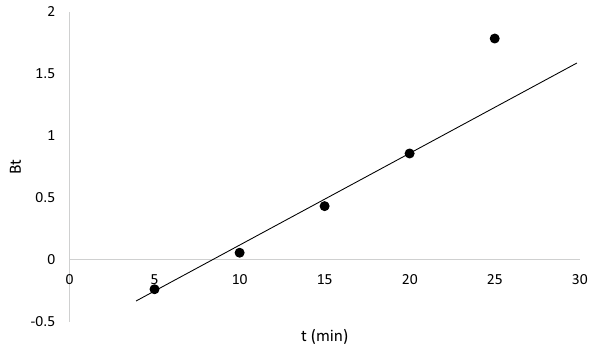
-0.500.511.522.53 Fig. 15 Van’t Hoff’s plot for adsorption of Rh-B on AgNPs. 1 g/l